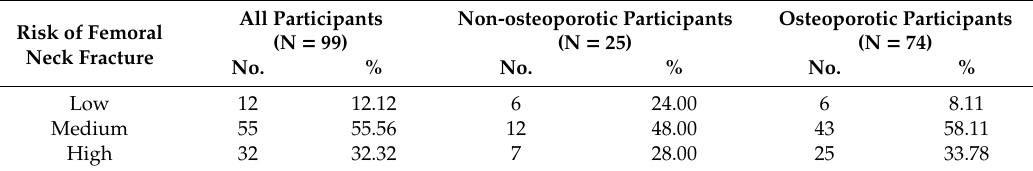
Table 6. The ten-year femoral neck fracture risk, according to the